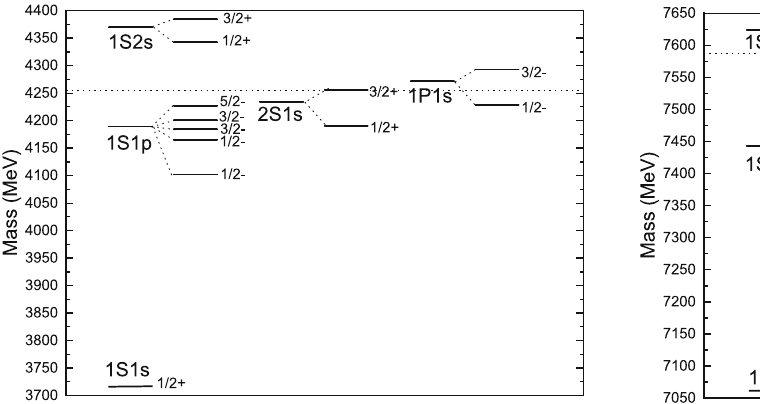
Fig. 5 Mass spectrum (in MeV) of the (cid:3) cc baryons, corresponding to the Table 13. The horizontal dashed line shows the (cid:4) c D s threshold